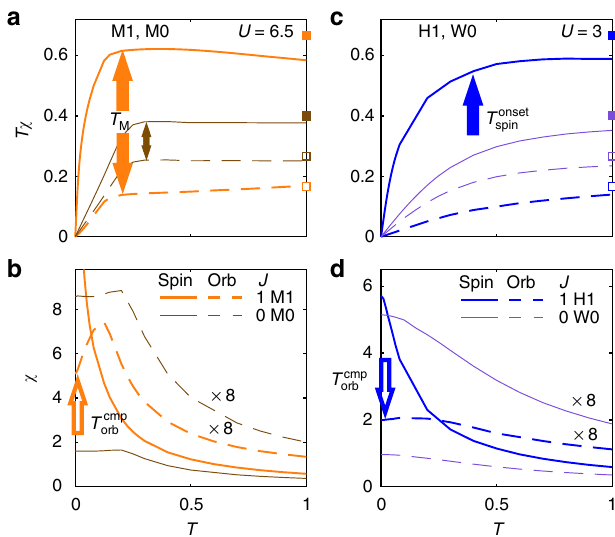
Fig. 6 Disentangling features of Mott and Hund physics in a DMFT + NRG study of the 3HHM: static local susceptibilities. The local spin and orbital susceptibilities are shown as functions of T for M1 (orange) and M0 (brown) in ( a , b ), and for H1 (blue) and W0 (purple) in ( c , d ), with T χ depicted in the upper panels ( a , c ) and χ in the lower panels ( b , d ). a , c For temperatures well above T onset or T onset , respectively, T χ orb and T χ spin spin orb approach plateaus, indicative of a Curie law, as expected for unscreened spin or orbital degrees of freedom. The observed plateau heights are roughly comparable to the values expected 46 for free local moments with occupancy strictly equal to 2 and, for M1 and H1 (M0 and W0), spin equal ¼ 1 h ^ S 2 i ¼ 2 = 3 ð 2 = 5 Þ and T χ free ¼ 1 h ^ T 2 i ¼ to 1 (and 0), for which T χ free 3 8 spin orb 1 = 6 ð 4 = 15 Þ indicated by fi lled and empty squares on the right vertical axes, respectively. (Deviations of the observed plateaus from these local moment values re fl ect admixtures of states with different occupancy or spin, see Supplementary Fig. 3.) For M1 in ( a ), the Curie law ceases to hold for both χ χ ’ 0 : 2 ( fi lled orange arrows). For H1 in ( c ), orb and spin below about T M χ ’ 0 : 4 ( fi lled blue spin deviates from a Curie-like behavior below about T arrow), while χ orb does not follow a Curie law in the temperature range displayed. For M0 in ( a ) and W0 in ( c ), deviations from Curie behavior set in at similar temperatures for χ spin and χ orb , since χ spin = 1.5 χ orb for J = 0 (M0: small brown double arrow, W0: outside temperatures range of plot). Thus the onset of screening shows spin-orbital separation for H1, but not for M1 (due to its proximity to the Mott transition), and also not for M0 and W0 (since these have J = 0). b , d For both M1 and H1, χ spin saturates at very low Fermi-liquid temperatures (not displayed here, but clearly deducible from the underlying zero-temperature NRG data 9,10 ). By contrast, χ = 0.01 (open orb is approximately temperature independent below T orange arrow) for M1 in ( b ) and below T = 0.03 (open blue arrow) for H1 in ( d ). For M0 in ( b ) and W0 in ( d ), χ orb and χ spin become temperature independent at similar temperatures. Thus, the completion of screening shows tendencies of spin – orbital separation for M1 and H1 (since J ≠ 0), but not for M0 and W0 (since J = 0). Moreover, T cmp and hence T FL is much spin smaller for J ≠ 0 than for J =